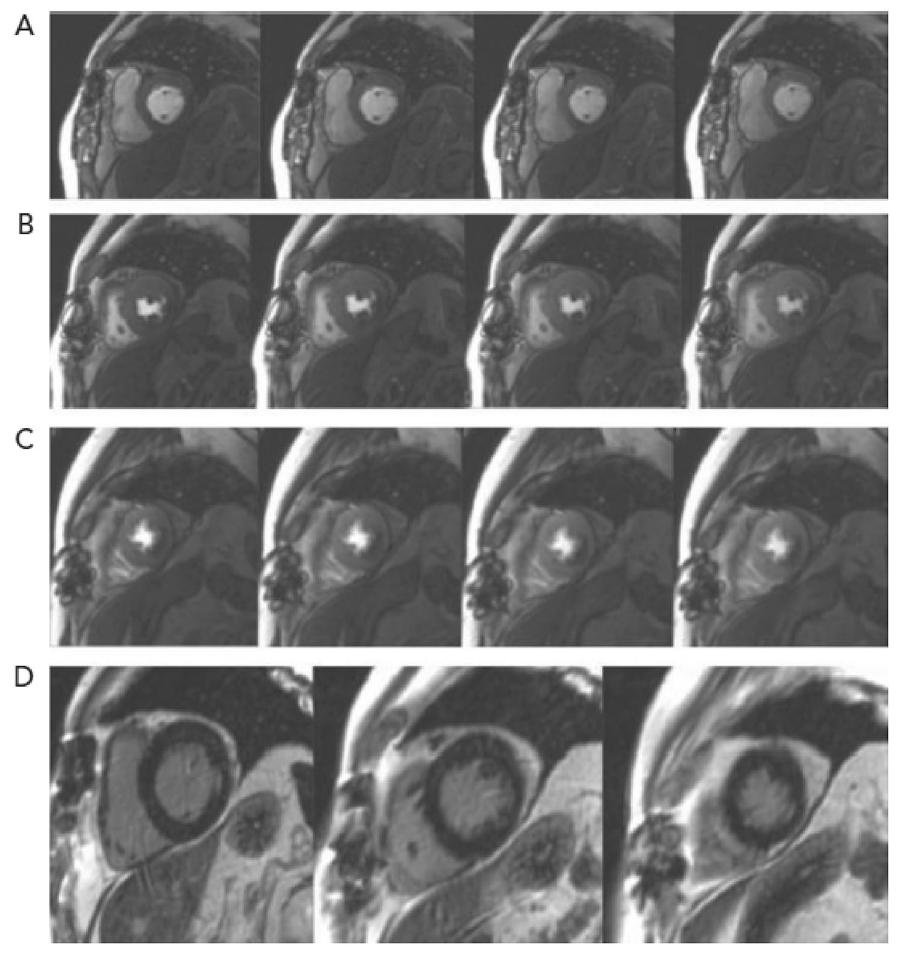
Figure 1. CMRI shows perfusion in four consecutive cardiovascular cycles in the short axis slices in the base ( A ), mid ( B ), and apical left ventricular portions ( C ). Panel ( D ) shows late gadolinium enhancement pictures in similar sections. There is significant ischemia in the inferior and inferolateral wall 10